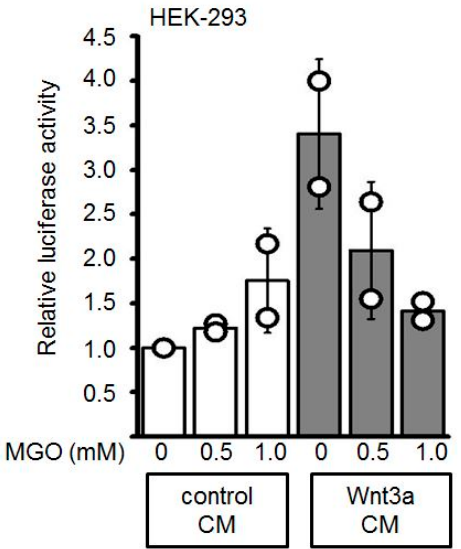
Figure A1. The stimulating activity of Wnt3a-conditioned media (Wnt3a CM) was suppressed after MGO-treatment in reporter gene assays. The activity of Wnt3a-conditioned media (Wnt3a CM) was suppressed after methylglyoxal (MGO)-treatment in Topflash / Fopflash reporter gene assays in HEK-293 cells. The graph shows mean values ± SD. Circles represent individual experiments. n = 2.